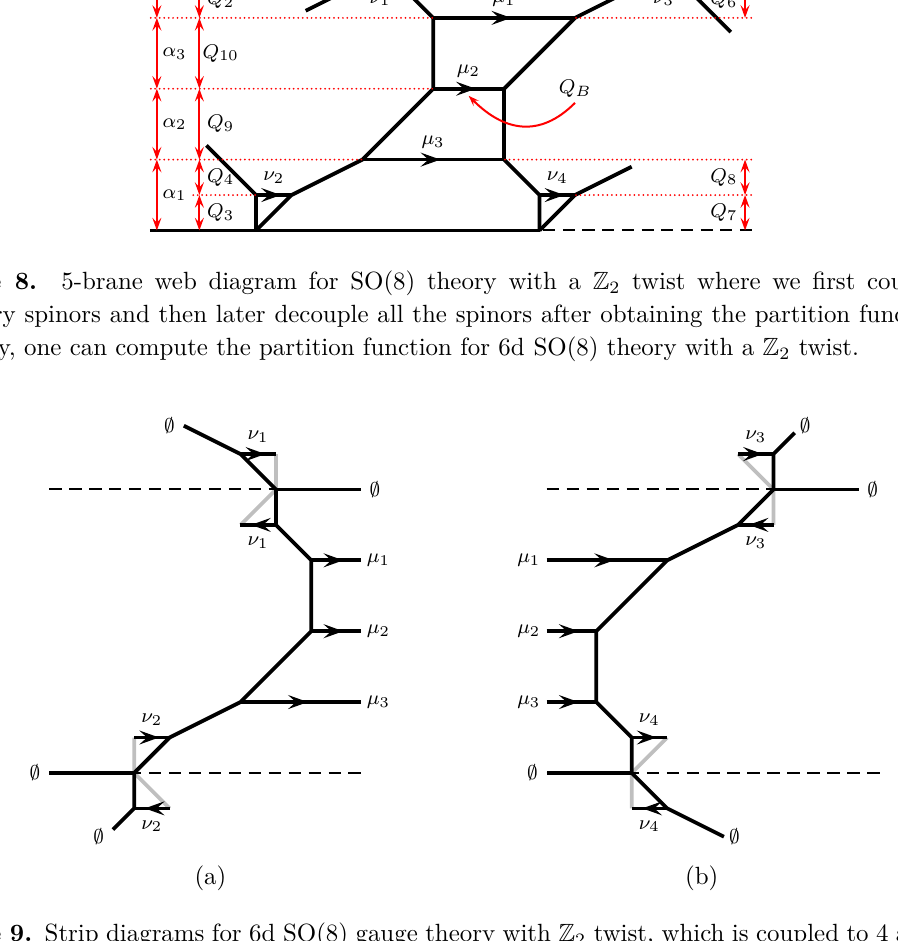
Figure 9. Strip diagrams for 6d SO(8) gauge theory with Z 2 twist, which is coupled to 4 auxiliary spinors. They are the left part (a) and the right part (b) of figure 8. We use mirror images to make each part as a form of a strip